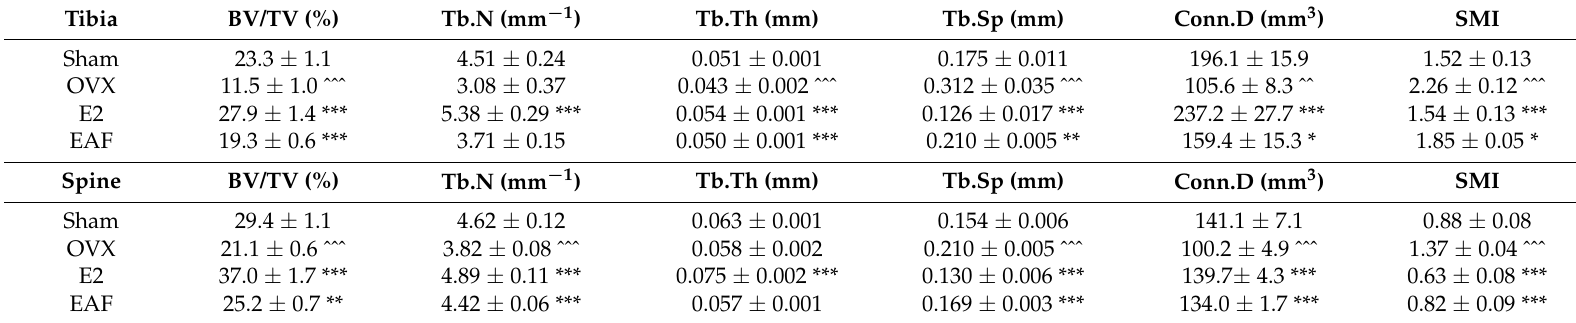
Table 2. Effect of EAF on bone mineral density (BMD) and bone microarchitecture at the proximal tibia and lumbar vertebra L4 in ovariectomised (OVX) mice analyzed by